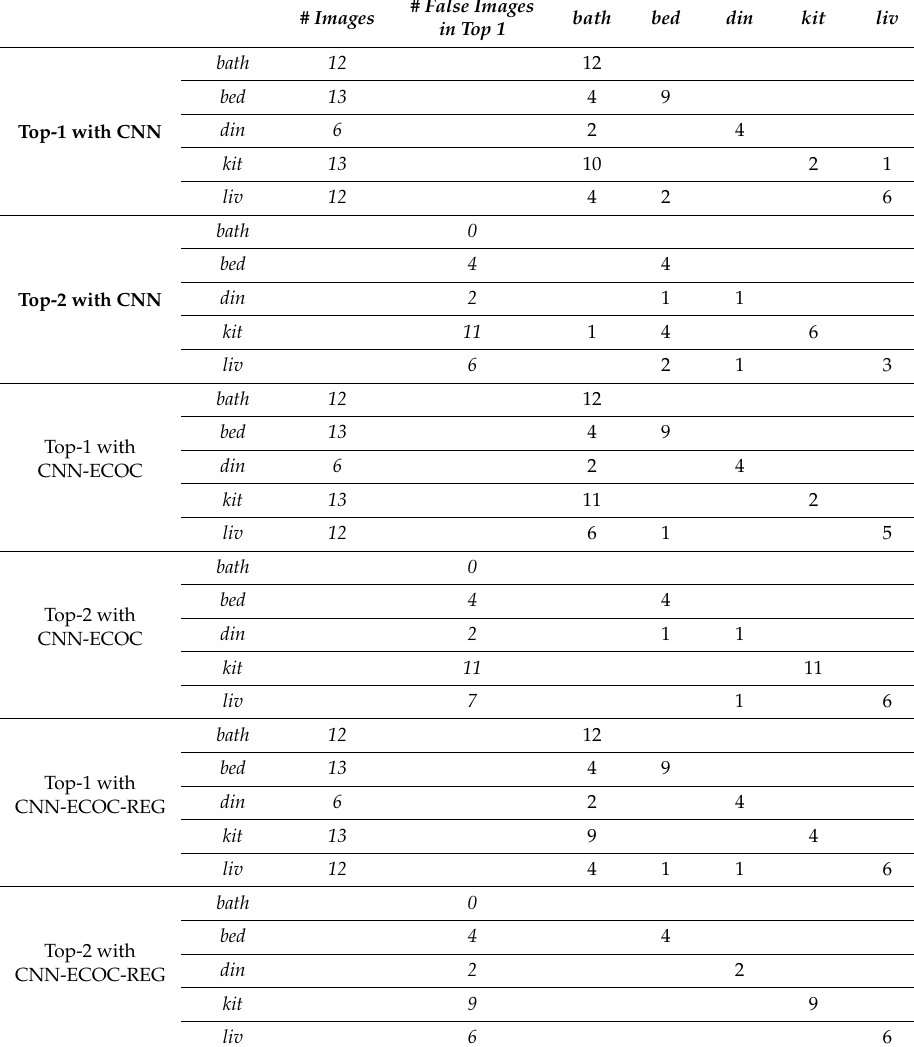
Table 5. Confusion matrix of testing images with top-1 & top-2 for five